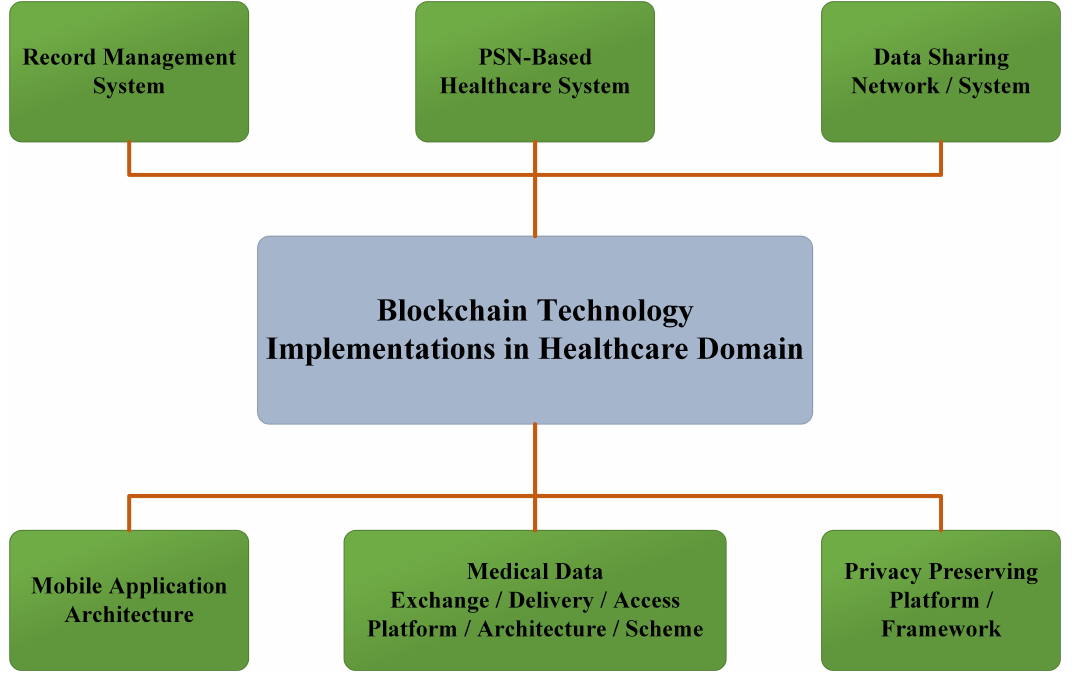
Figure 5. Blockchain implementation in